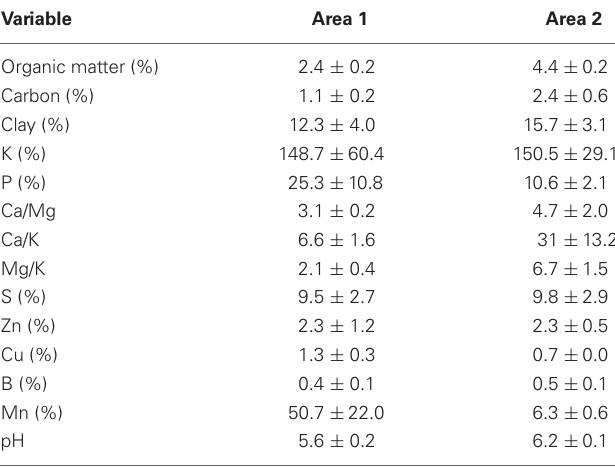
Table 1 | Results of chemical analyses of soil from the sampling sites.